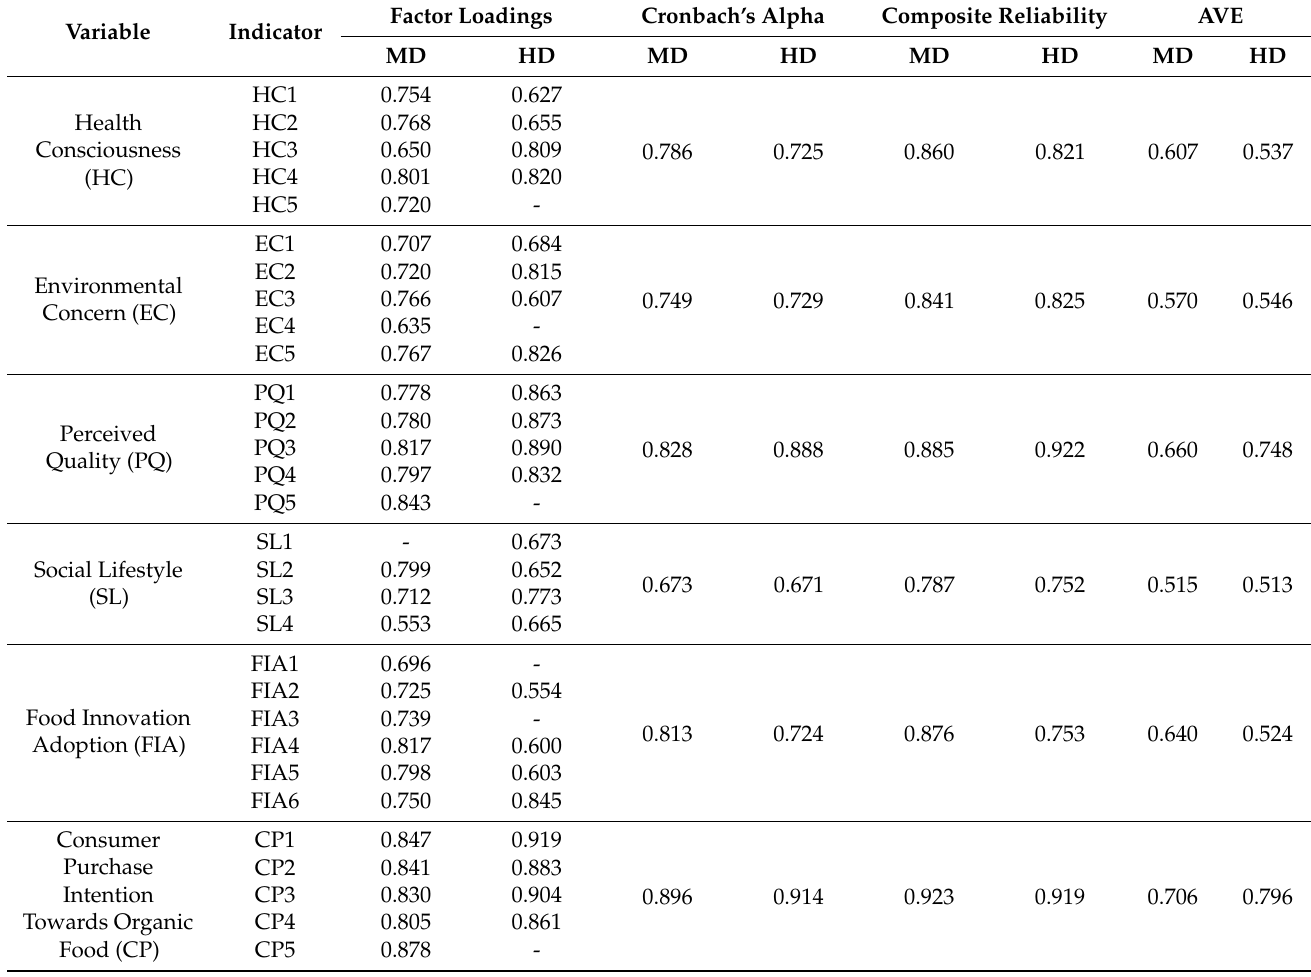
Table 3. Internal consistency, composite reliability and convergent validity.